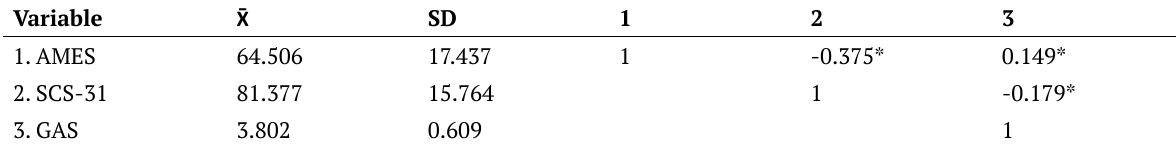
Table 3. Descriptive Statistics and Correlation Test Results